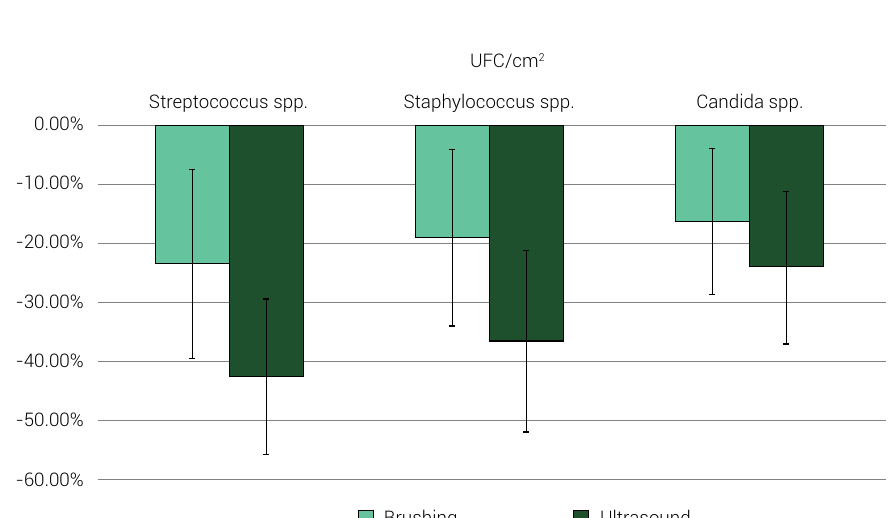
Figure 3. Mean and 95% confidence intervals of percentage change of microbial